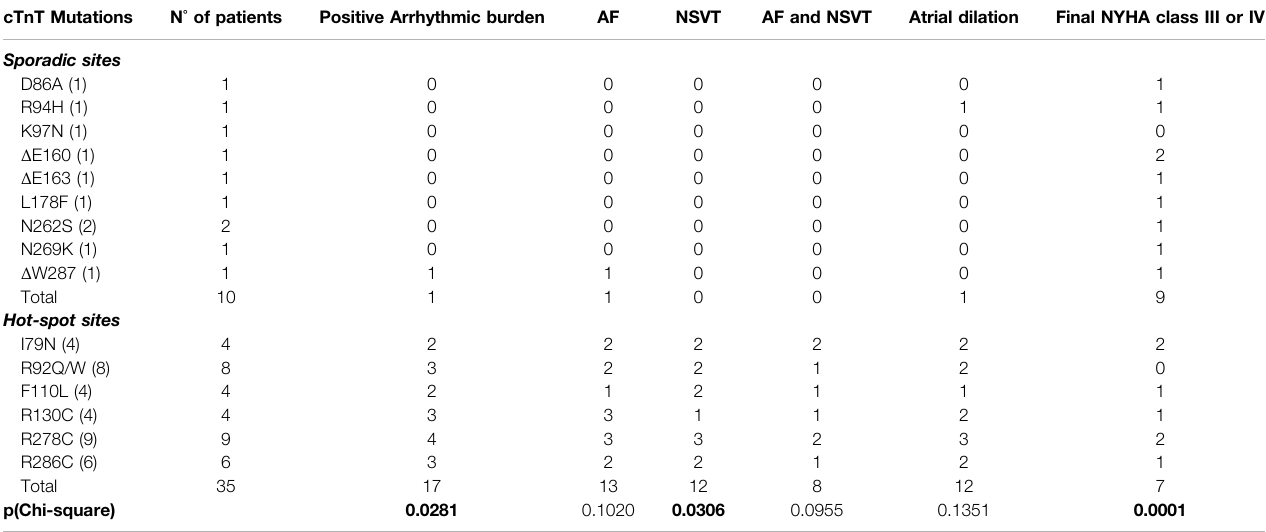
TABLE 1 | TNNT2 sporadic and hot spot mutations associated to Hypertrophic CardioMyopathy (HCM) and prevalence of arrhythmias and clinical phenotype. cTnT Mutations N ° of